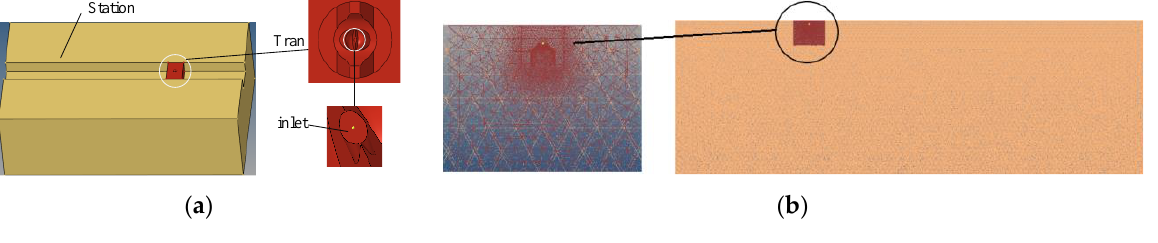
Figure 3. Computational domain and meshing of the plane spraying. ( a ) Computational domain. ( b ) Meshing.